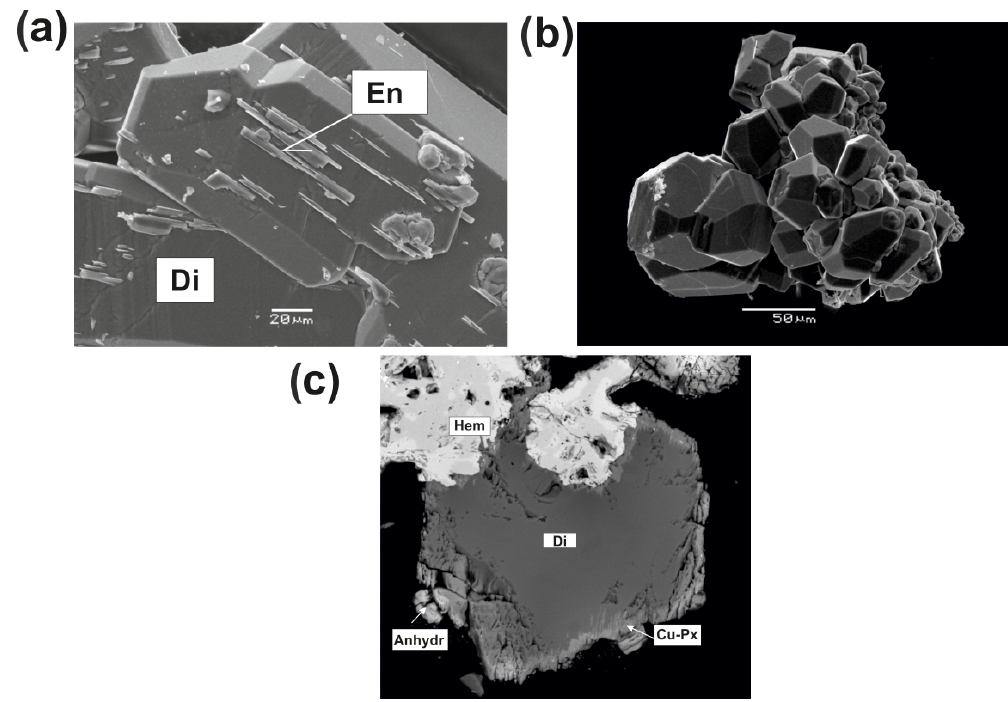
Figure 8. Pyroxenes from the Arsenatnaya fumarole: (a) diopside (Di) crystal overgrown by enstatite (En) crystals; (b) aggregates of well- shaped crystals of diopside; (c) crystal of diopside (Di) covered by thin crust of Cu,Mg-pyroxene (Cu-Px) in association with anhydrite (Anhydr) and hematite (Hem) (FOV width is 0.25mm). (a, c) BSE images; (b) SE